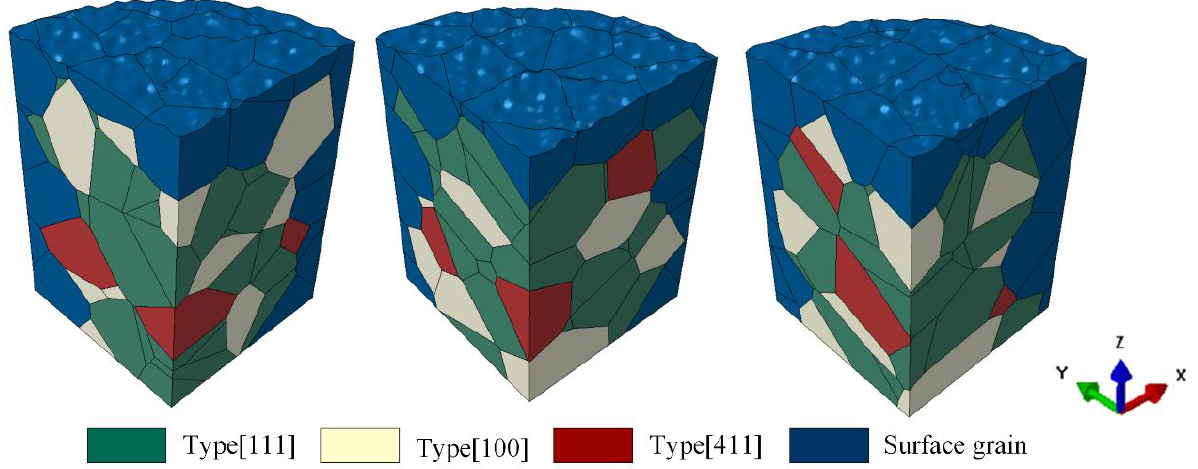
Figure 3. Three different grain orientations with the grain size of 50 μm .